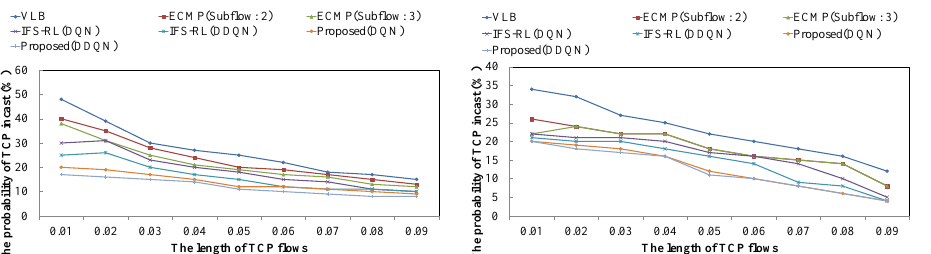
Figure 8. The probability of TCP incast occurrence against the length of TCP flows (( Left ): the case for complex architecture, ( Right ): the case for non-complex architecture).